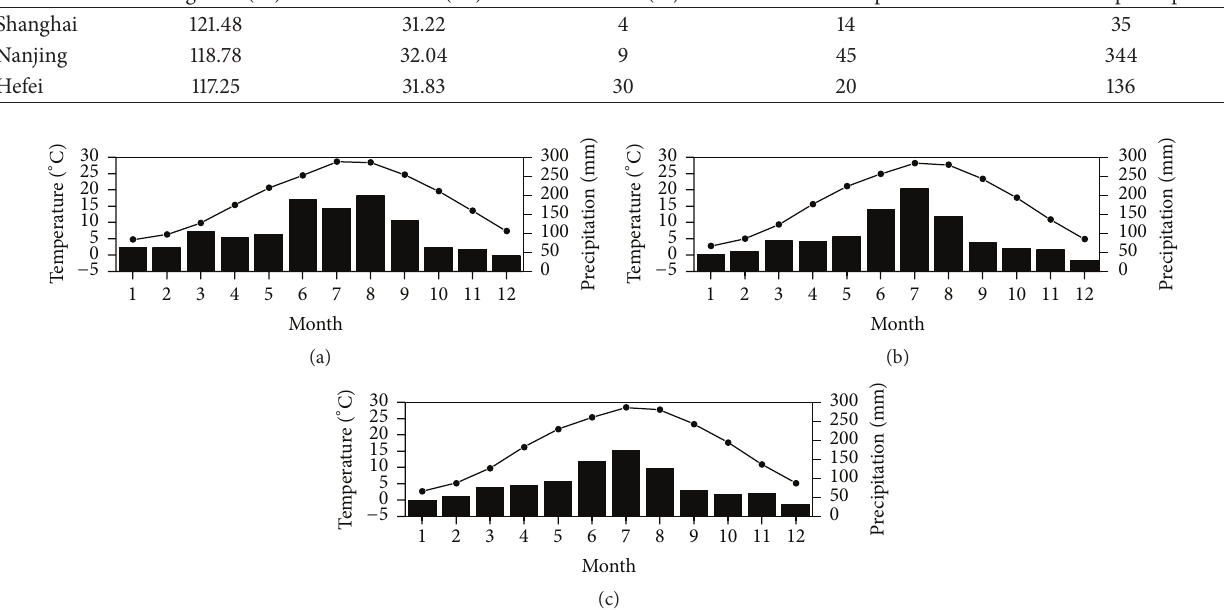
Figure 1: Annual mean temperature and average annual precipitation of the 3 stations (1987–2012). (a) Shanghai; (b) Nanjing; and (c) Hefei. The curves stand for monthly mean temperature, and the bars stand for monthly mean